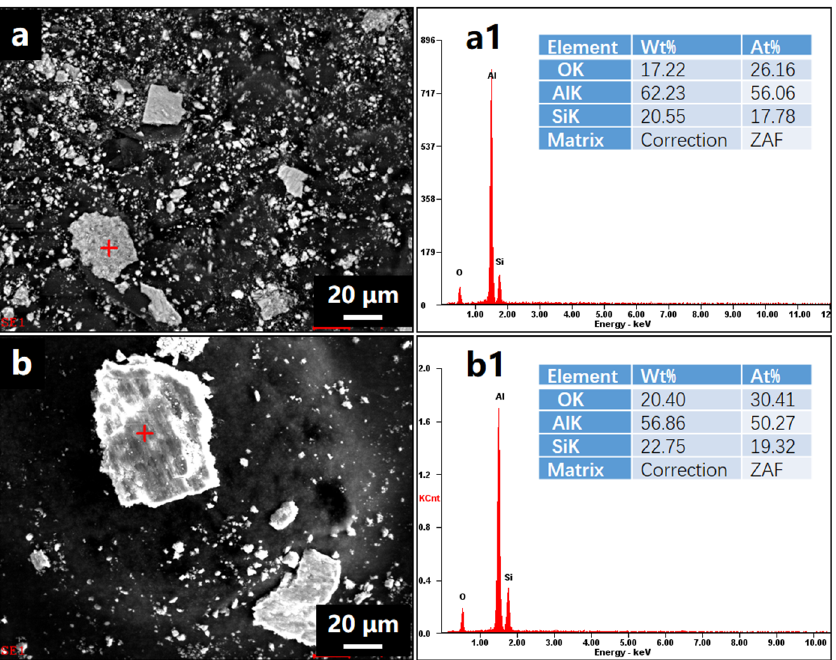
Figure 8. ( a , a1 ) The EDS composition analysis of wear debris of 30 °C, the red plus sign in Figure 8a is the EDS sampling point; ( b , b1 ) EDS composition analysis of wear debris of 150 °C, the red plus sign in Figure 8b is the EDS sampling point.